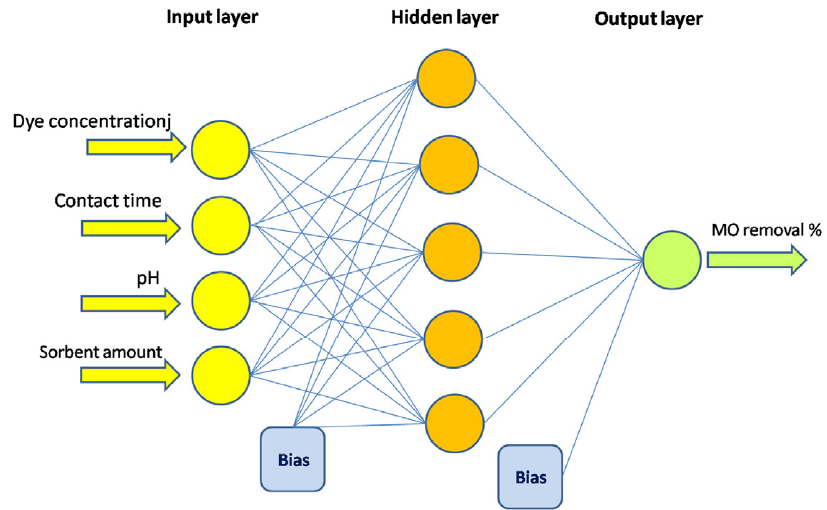
Fig. 9. ANN optimized structure. Table 4. Matrix of weights between input and hidden layers in optimized ANN. Table 4. Matrix of weights between input and hidden layers in optimized ANN.